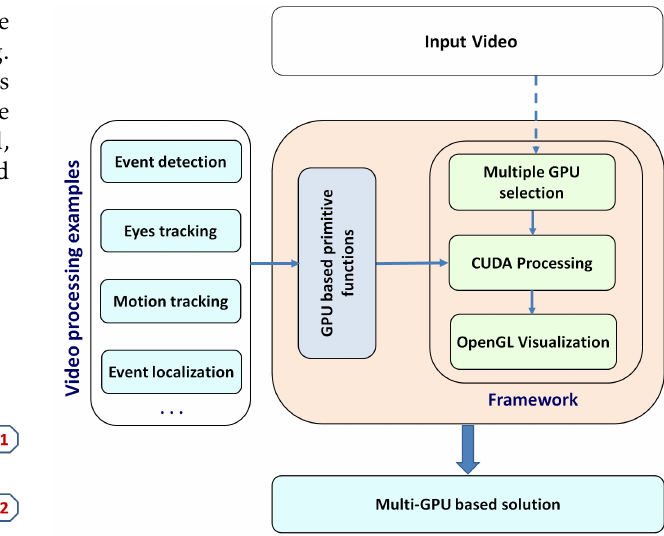
Figure 2. Exploitation process of our framework